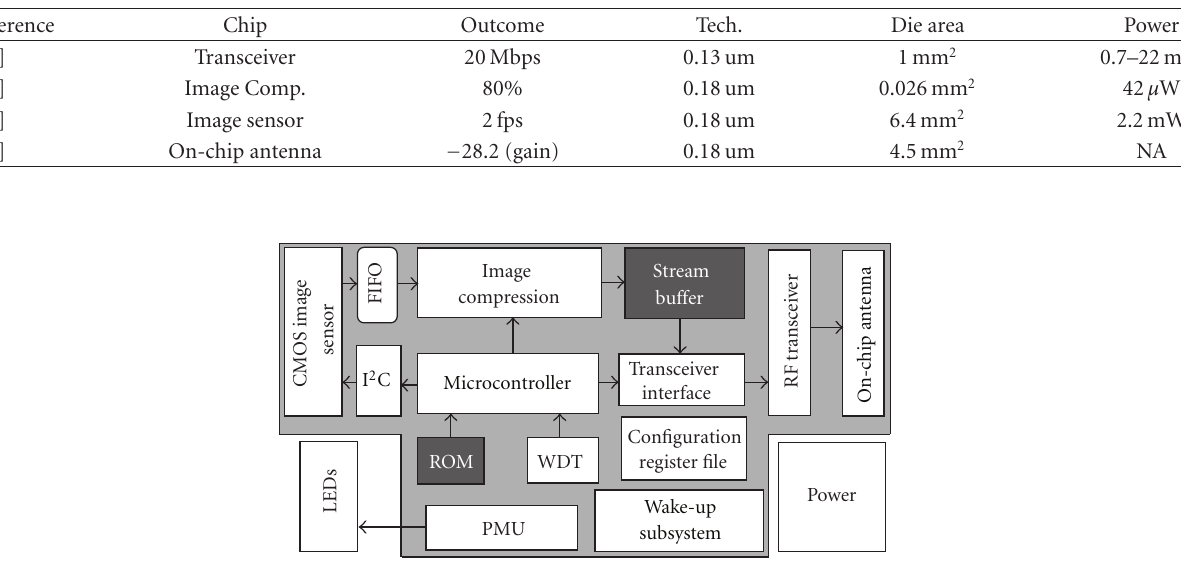
Table 3: The best research outcome in capsule device optimization.